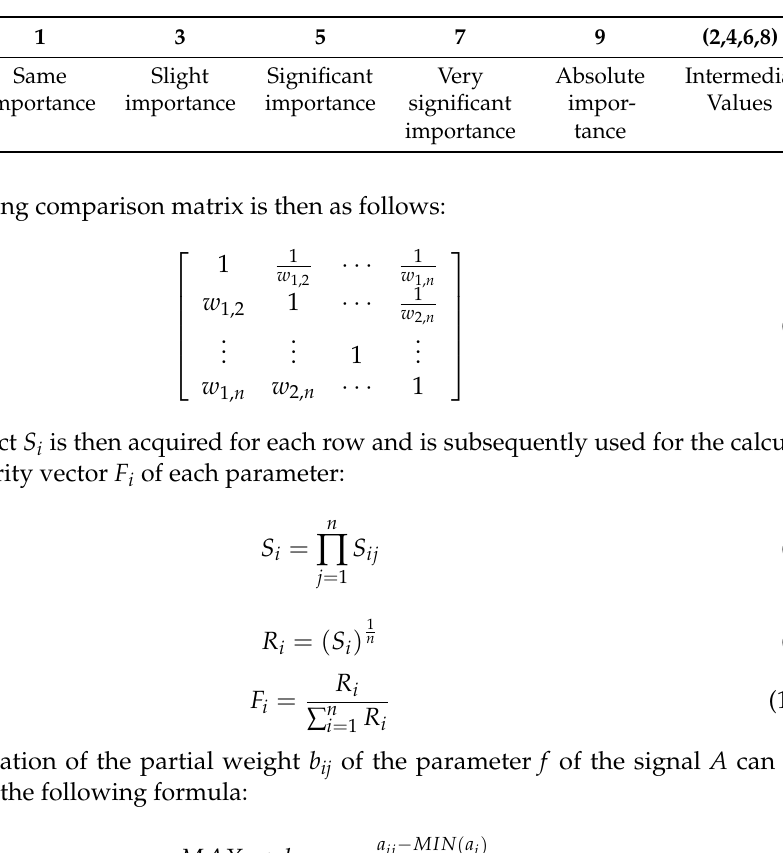
Table 1. Saaty’s scale